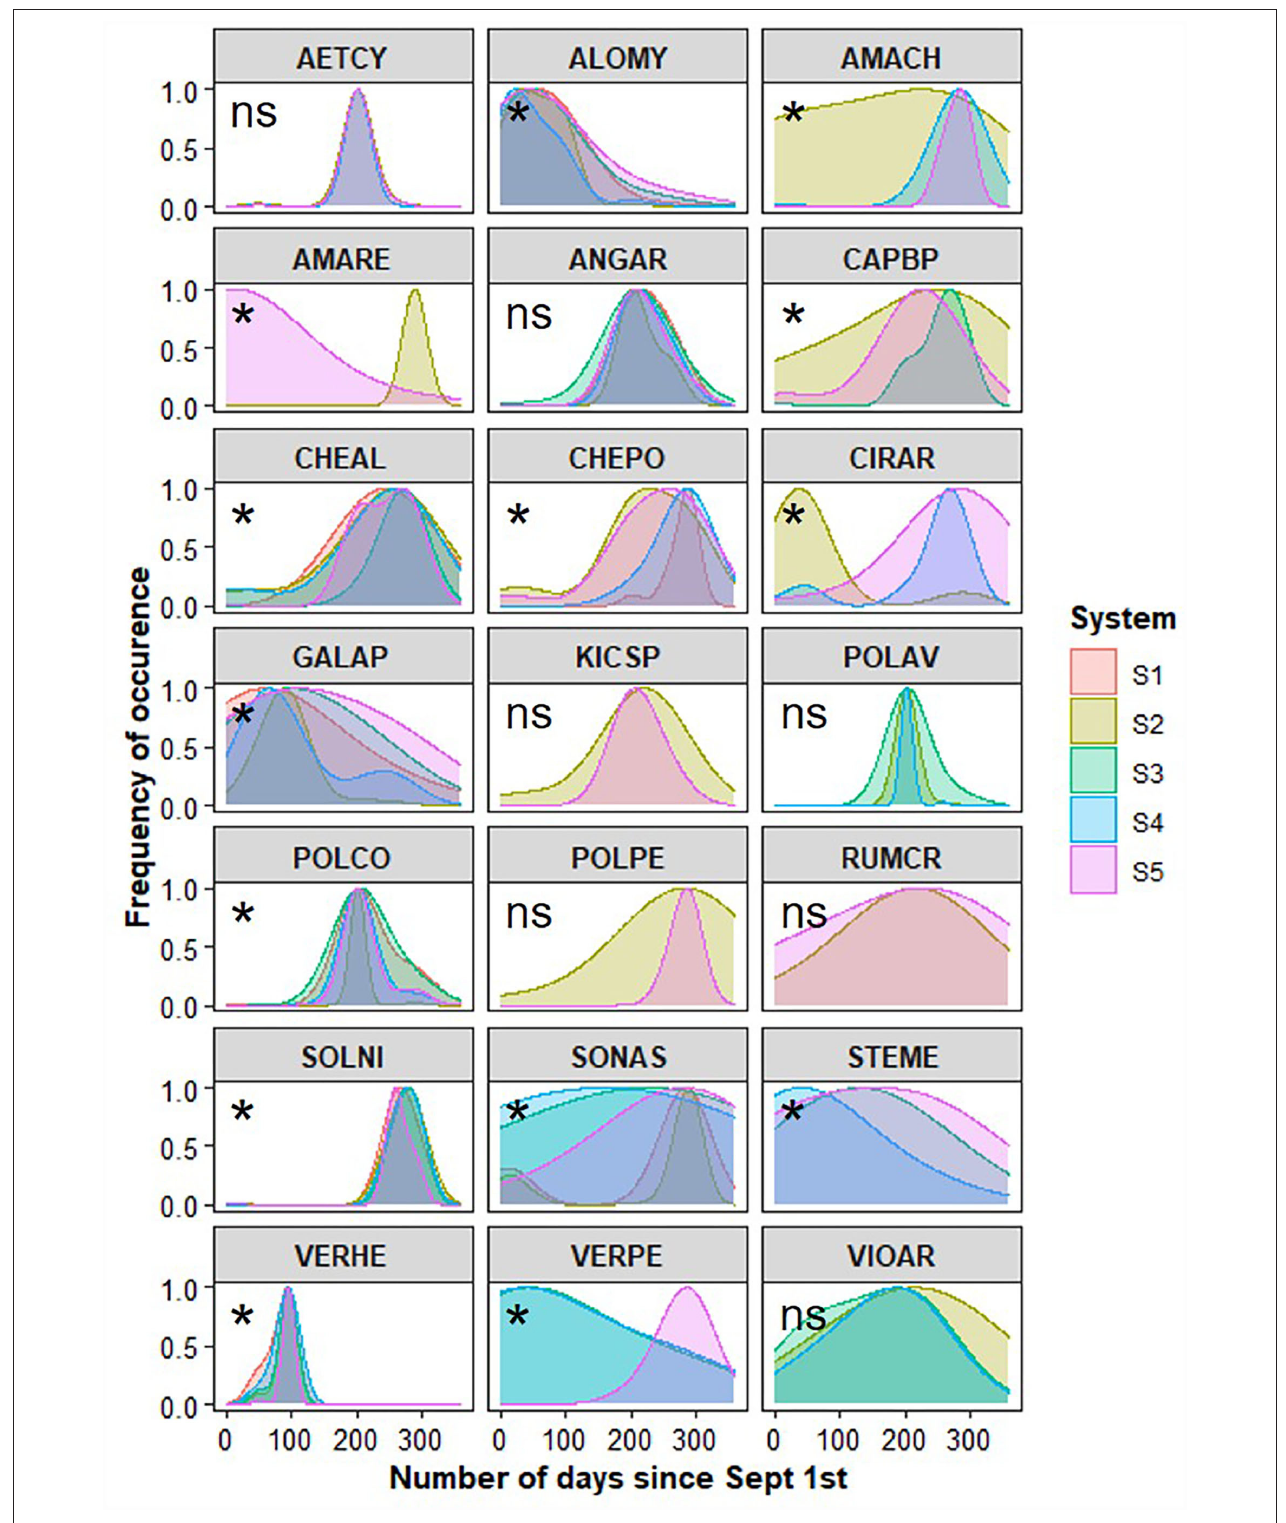
FIGURE 4 | Distribution of emerged seedlings per weed species (named by EPPO code) in each cropping system (S1–S5) during the superficial germinable seedbank experiment in which strips were tilled every 6 weeks over the growing season. Significance of overlap between pairs of systems was tested with a randomization procedure (*at least one overlap is significantly different, ns: no significant difference in overlap, see detailed overlap values and significance in Supplementary Table 3 ).